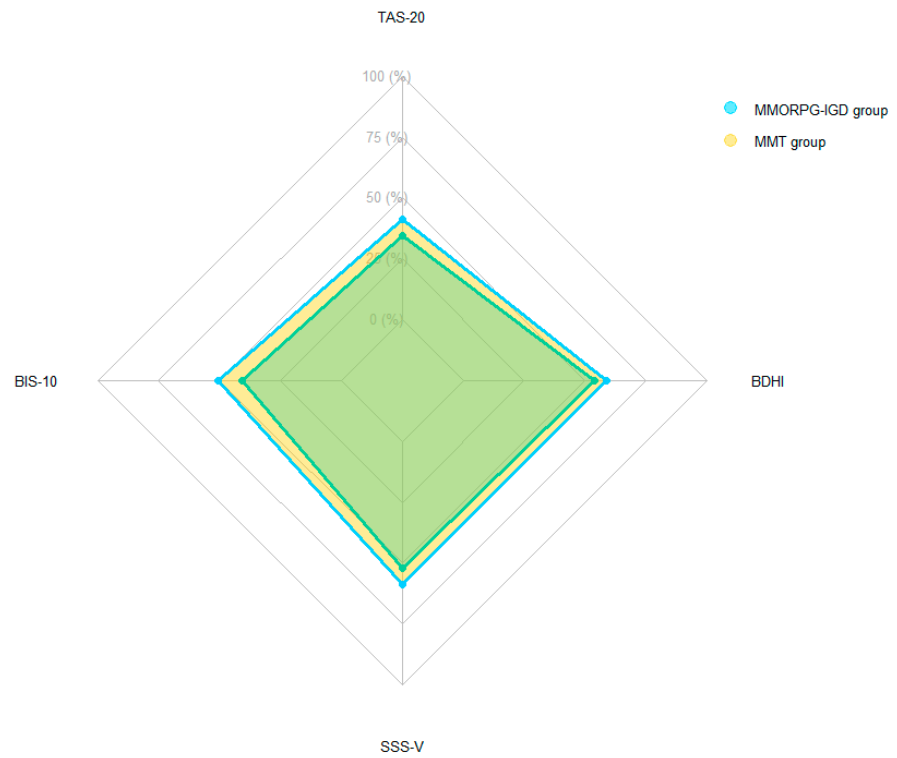
Figure 2. Radar plot of psychometric scales for both groups. MMORPG-IGD, massively multiplayer online role-playing game internet gaming disorder; MMT, methadone maintenance therapy; TAS-20, Toronto Alexithymia Scale; BIS-10, Barratt-Impulsiveness Scale, version 10; BDHI, Buss-Durkee Hostility Inventory; SSS-V, Zuckerman Sensation Seeking Scale, form V.